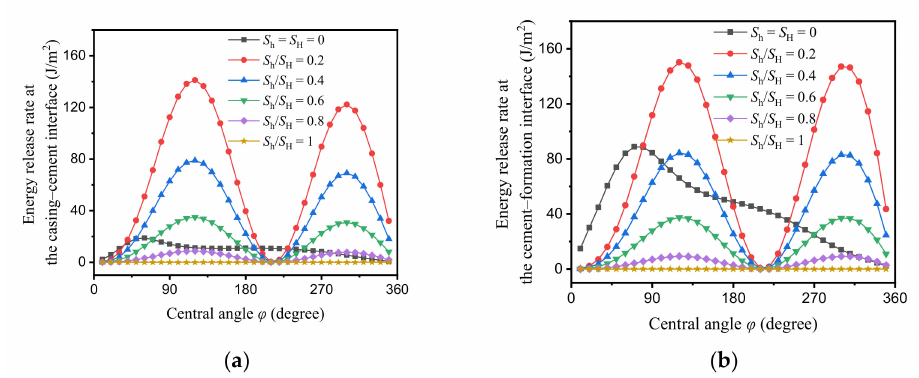
Figure 12. Impacts of in situ horizontal stresses on interfacial debonding: ( a ) crack at the casing-cement interface; ( b ) crack at the cement-formation